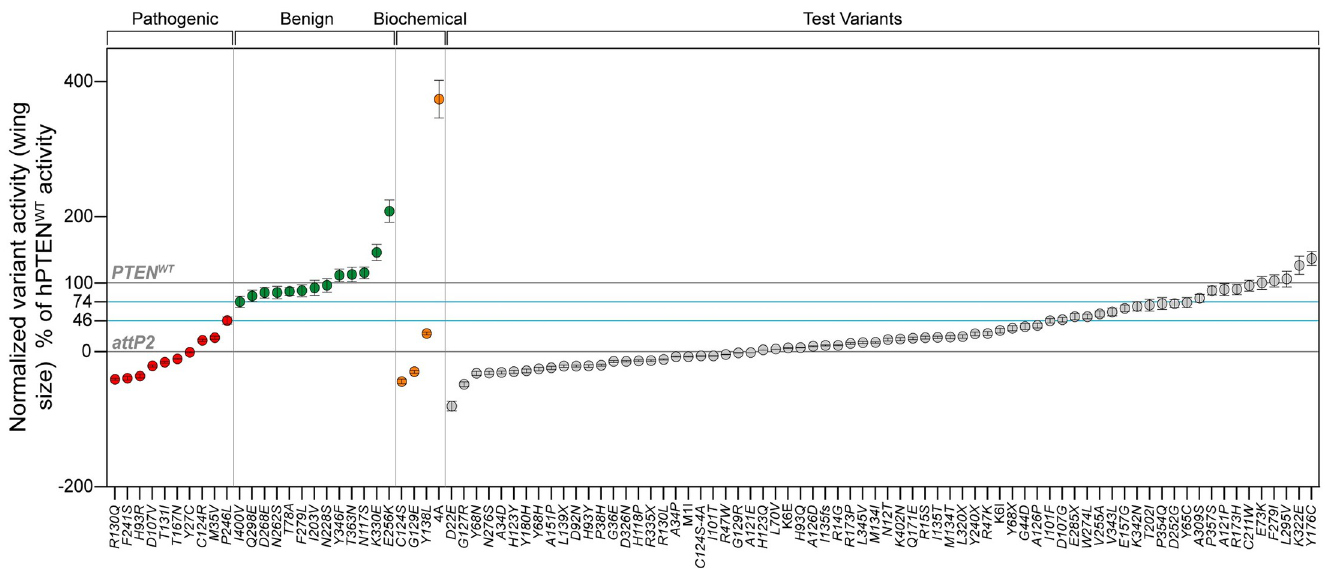
Fig 8. Categorization of PTEN variants in wing size assay for clinical interpretation. Assessment of the wing size assay for clinical interpretation was performed using the criteria established by ClinGen PTEN Expert Panel (see S2 Table). Normalized variant activity is shown as % of PTEN-WT activity (0 = attp2 and 100 = PTEN-WT) calibrated using 10 pathogenic (all Expert panel reviewed in ClinVar), 13 benign (classified based on their normal function in three independent assays), and 4 biochemically-characterized variants. The assay successfully classified pathogenic and benign control variants into distinct functional groups concordant with their classified function. The additional 66 test variants were classified as either normal or benign (over 74% of PTEN-WT activity), abnormal or pathogenic (less than 46% of PTEN-WT activity) or intermediate or indeterminate (46 to 74% of PTEN-WT activity). The wing size assay successfully discriminated classified pathogenic and benign control variants into discrete functional readouts that permitted us to establish thresholds for clinical interpretation. Each datum point represents an individual PTEN variant. Data are expressed as mean. Error bars indicate propagated error (relative standard deviation).